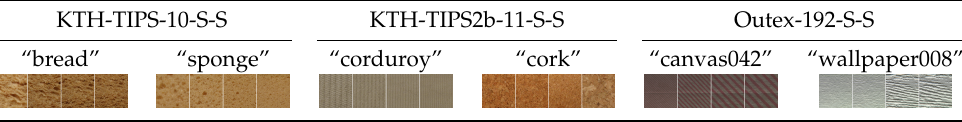
Figure 7. Group #7: Stationary textures with variations in scale (Section 3.2.7).